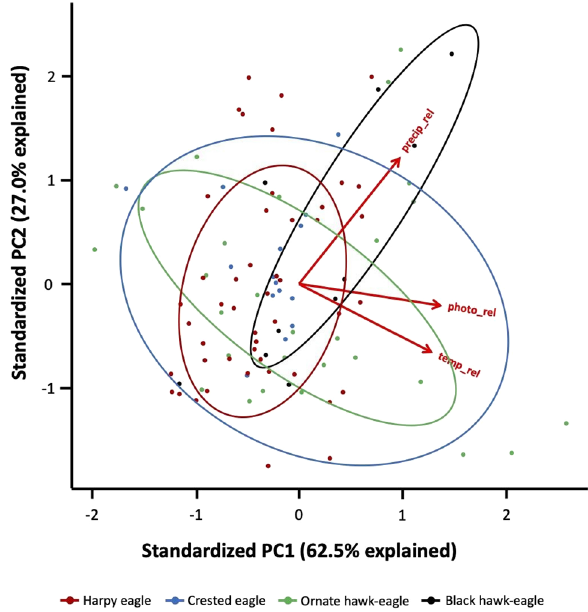
Figure 4. Principal Component Analysis (PCA) of the variables relative changes in photoperiod, temperature, and precipitation. The first principal component (x axes) explained 62.5% of the data variation and the second principal component explained 27% of the variation of the data variation. The ellipses define the region that contains 68% of the data for each eagle. The red arrows represent the loadings of each variable (relative photoperiod, relative temperature and relative precipitation). The values of the data in terms of the principal components were multiplied by -1 to facilitate the